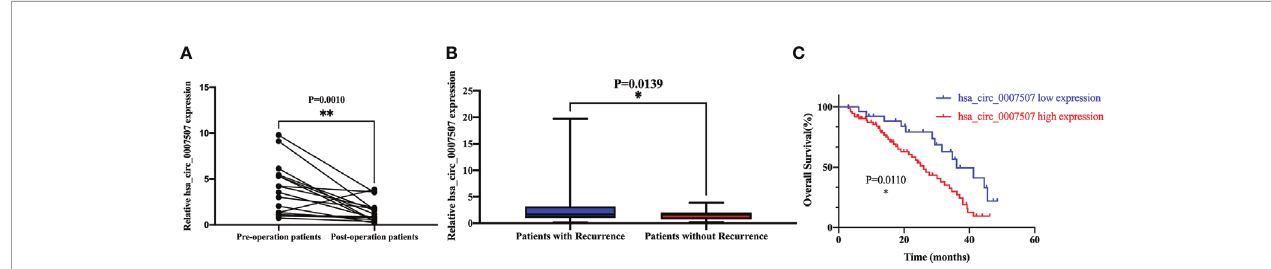
FIGURE 4 | Prognosticanalysis of hsa_circ_0007507. (A) Expression levelof hsa_circ_0007507 inGC patients decreased after operation (n=16, p=0.0010). (B) Differential expression of hsa_circ_0007507 in the serum of recurrent GC patients (n=65),and non-recurrent patients (n=36). (C) The Kaplan – Meier survival curve veri fi es the prognostic valueof hsa_circ_0007507. Indicatedstatistical signi fi cance (* p < 0.05, ** p < 0.01).